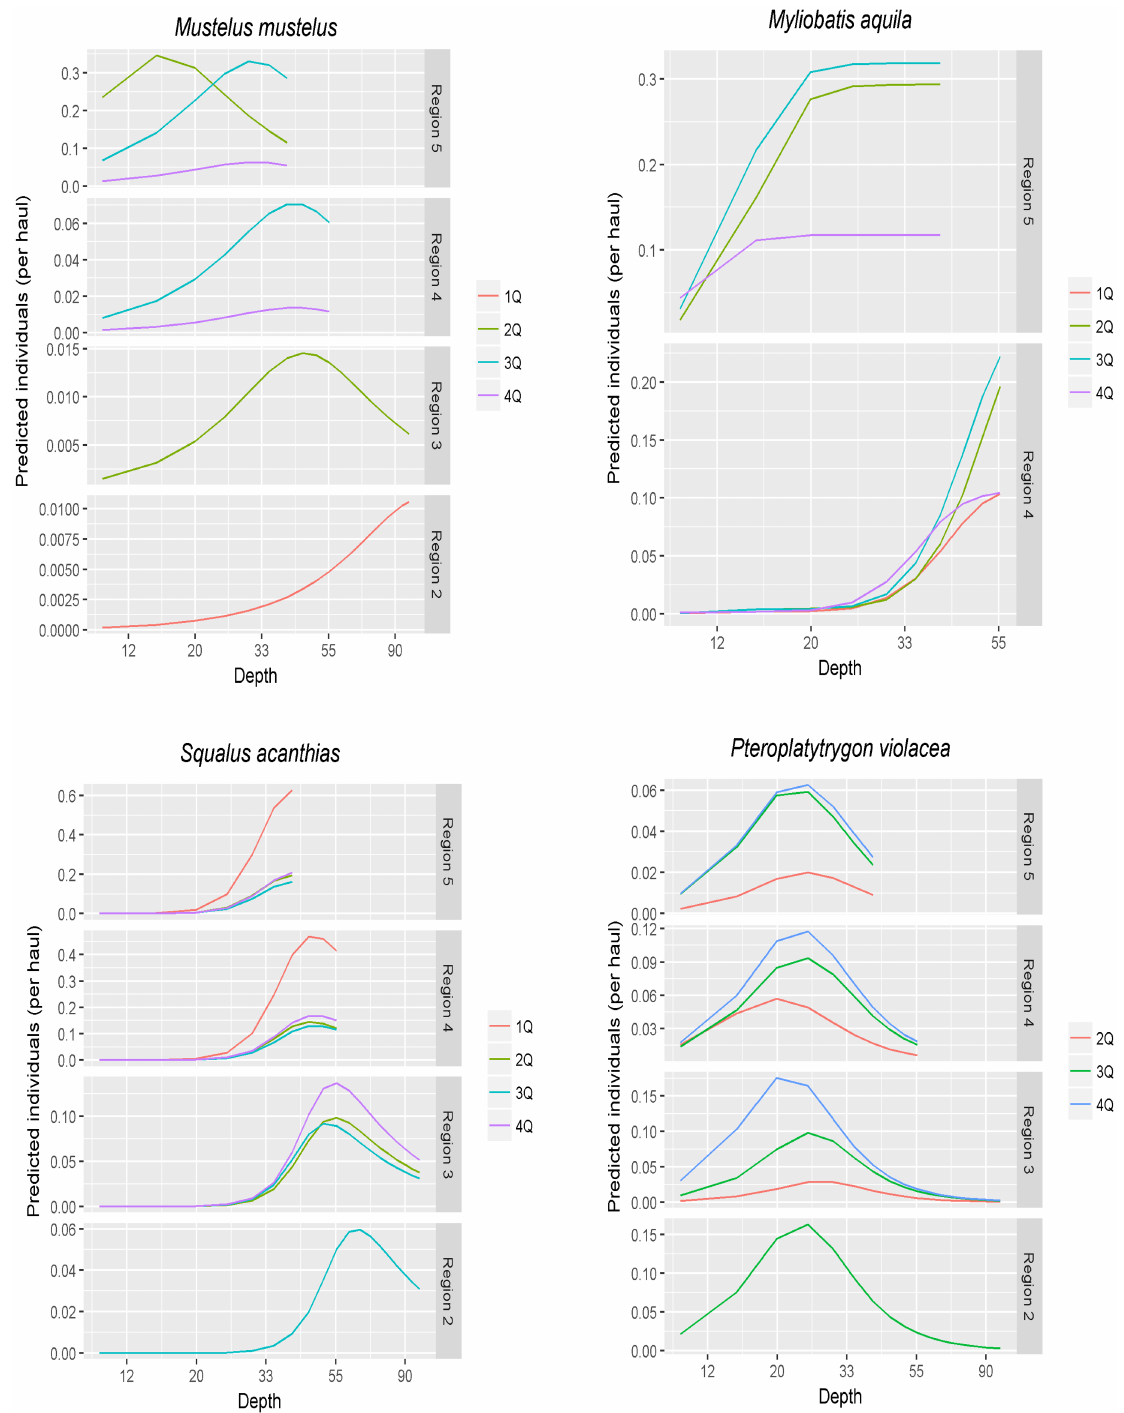
Fig 3. Predicted catch rate versus depth divided by regions (2–5) and quarters (1–4). For each species, only regions and quarters used in the CPUE standardization are reported.